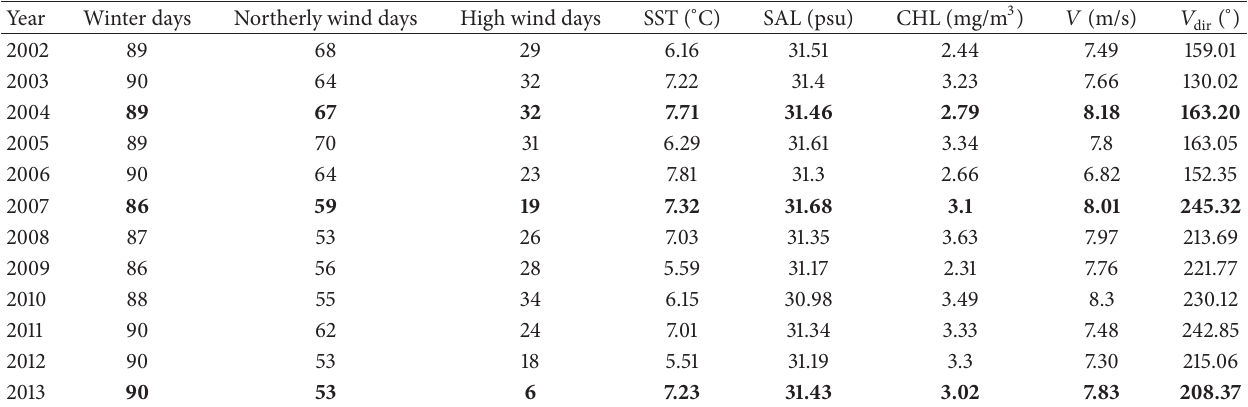
Figure 7: The SAL data from 42 cross section stations in Y-B on December 17–24, 2013: (a) sea surface; (b) 10m; (c) sea bottom (unit: psu). Table 3: Characteristics of the Y-B mixed zone in winter of